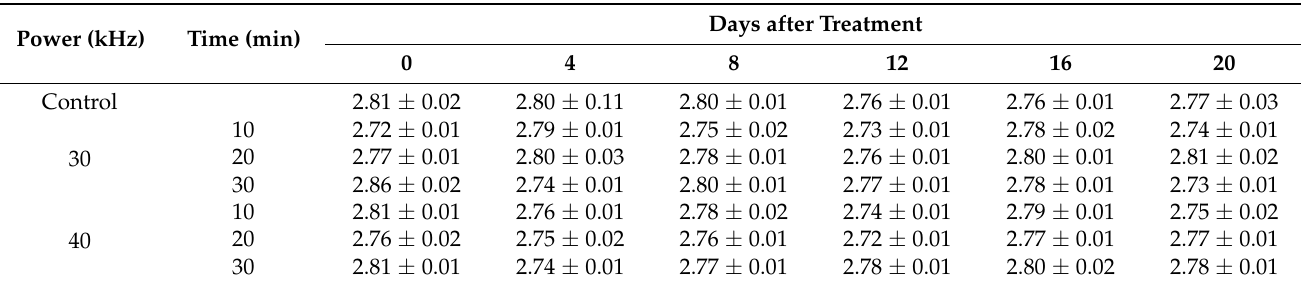
Table 1. Changes in pH during storage at 4 ◦ C of Passiflora edulis f. edulis Sims ( gulupa ) pulp subjected to low-frequency ultrasound treatments. Power